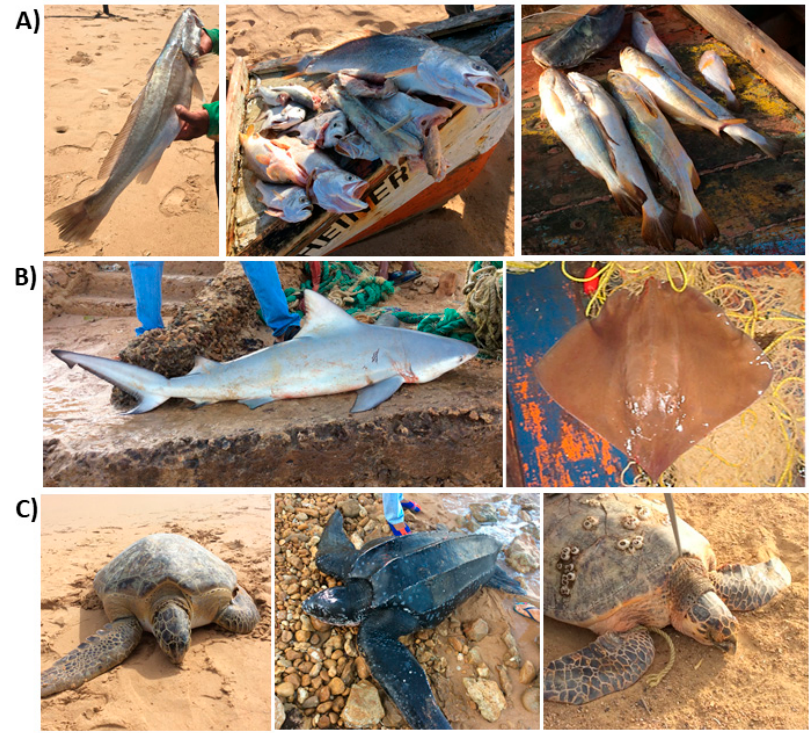
Figure 5. Marine animal species diversity of coastal eastern Guajira. ( A ). Commercial finfish (right: Cynoscion sp., and Rachycentron canadum ). ( B ). Cartilaginous fish (left: Carcharhinus perezi ; right: Dasyatis guttata ). ( C ). Marine turtles (left: Chelonia mydas ; middle: Dermochelys coriacea ; right: Eretmochelys imbricata ).